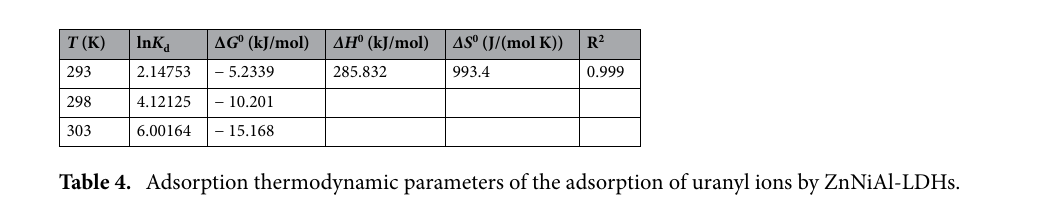
Figure 12. Effect of temperature ( a ) and the ln K d -1/ T diagram of ZnNiAl-LDHs on the adsorption of U(VI) ( b ) ( C